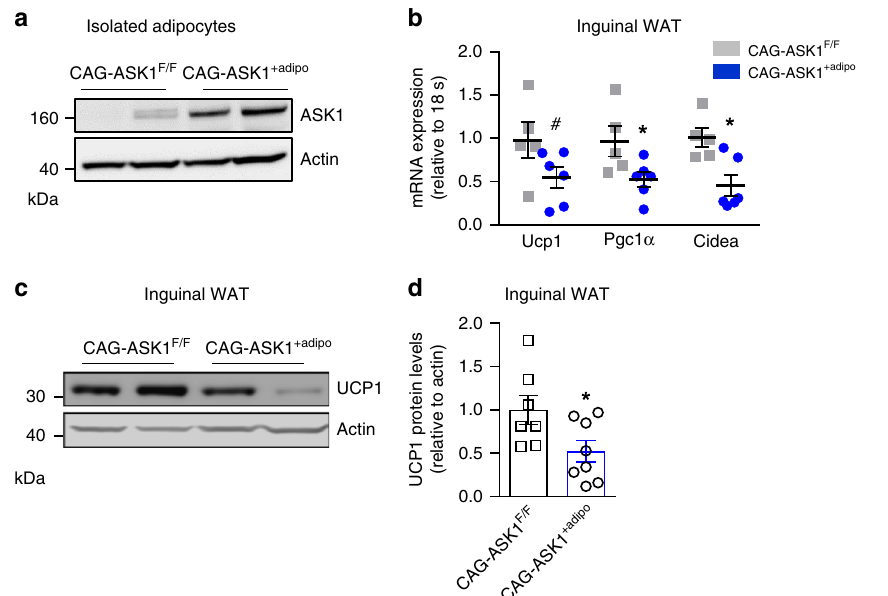
Fig. 5 Adipocyte-speci fi c ASK1 overexpression decreases adipose tissue browning. a Protein levels of ASK1 in lysate of isolated adipocytes harvested from CAG-ASK1 F/F and CAG-ASK1 + adipo mice ( n = 2 mice per group). b mRNA expression of respective genes in inguinal adipose tissue of cold-exposed CAG-ASK1 F/F ( n = 5) and CAG-ASK1 + adipo ( n = 6) mice. # p = 0.094, * p = 0.042, * p = 0.017. c , d Representative western blot and quanti fi cation of UCP1 protein levels in inguinal adipose tissue harvested from cold-exposed CAG-ASK1 F/F ( n = 7) and CAG-ASK1 + adipo ( n = 8) mice. * p = 0.037. Values are expressed as mean ± SEM. Statistical tests used: two-sided t -tests for ( b ) (Ucp1 and Pgc1 α ), d two-sided Mann – Whitney for ( b ) (Cidea). Source data are provided as a Source Data fi